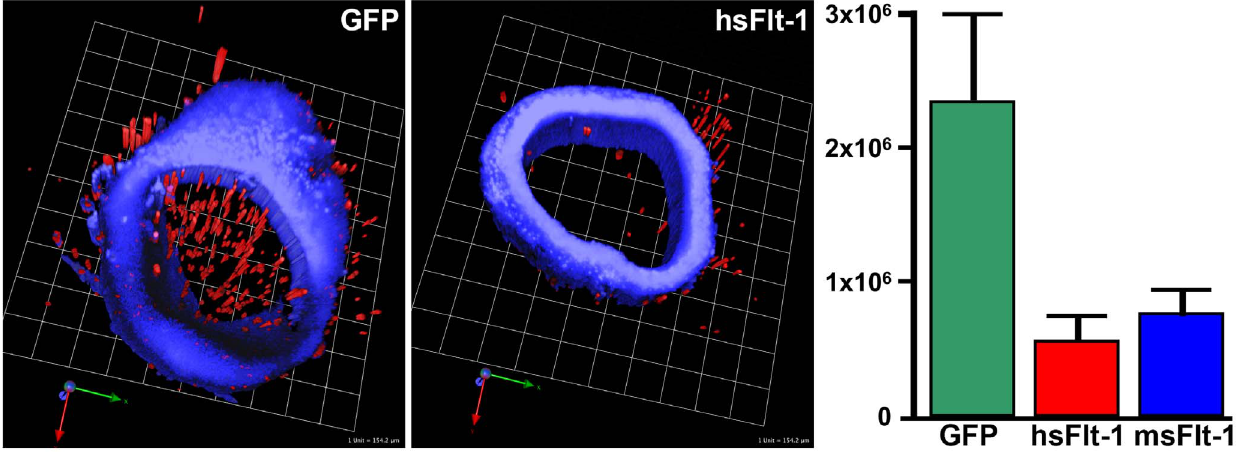
Figure 8. Aortic ring assays. Three dimensional reconstruction of confocal microscopic images of aortic rings from a mouse overexpressing GFP (left) or hsFlt-1-e15a (middle). Blue (4’,6-diamidino-2-phenylindole, DAPI) depicts nuclei in the aortic rings, while red represents microvessel outgrowth volumes. The bar chart (right) depicts the differences in mean microvessel outgrowth volumes between the groups. Microvessel outgrowth from aortic rings was significantly decreased in hsFlt-1-e15a (p=0.007) and msFlt-1(1-3)-treated (p=0.02) mice compared to control animals.